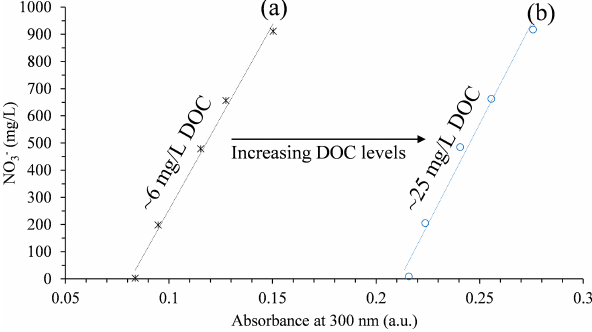
Figure 1. Nitrate concentration vs. absorption at 300nm of soil wa- ter samples from the conventional